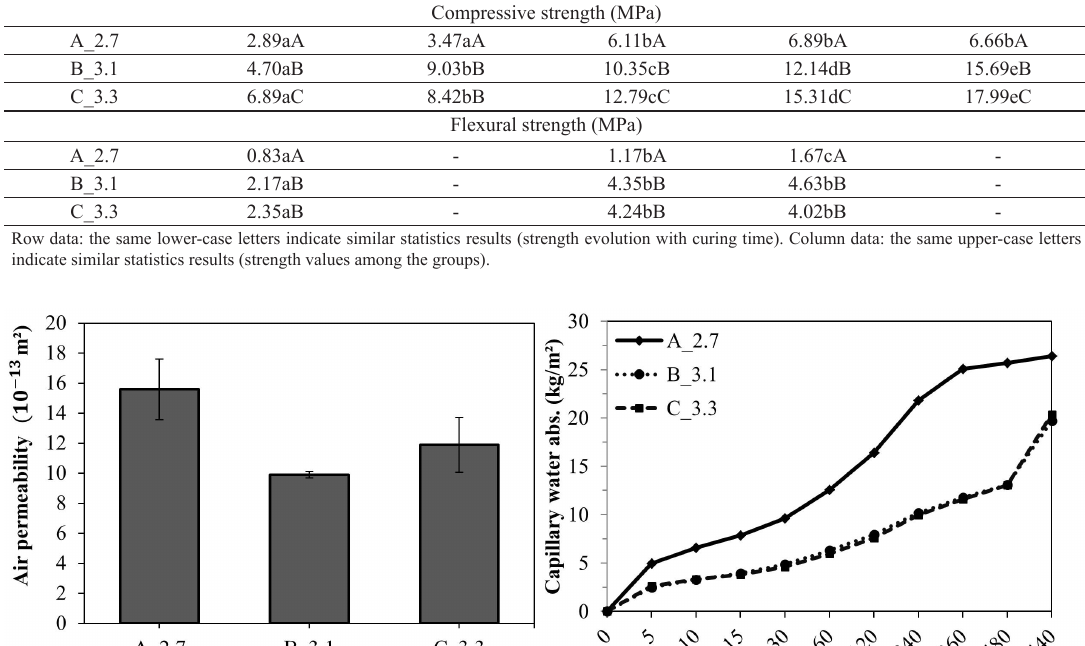
Table 5. LSD test with a 95% confidence limit.